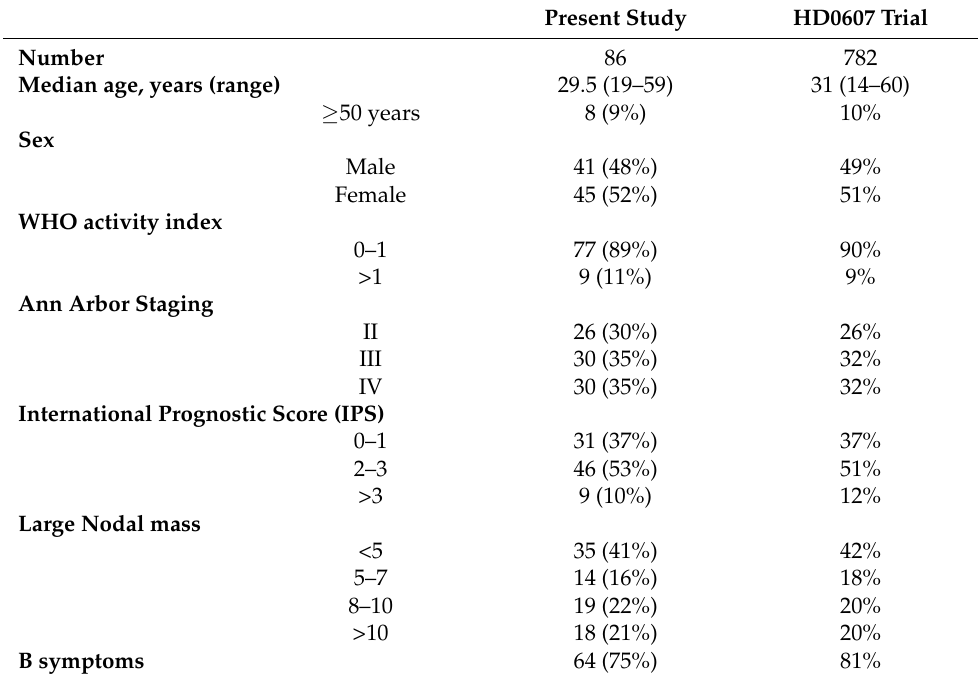
Table 1. Clinical characteristics of evaluated patients and comparison with the original source